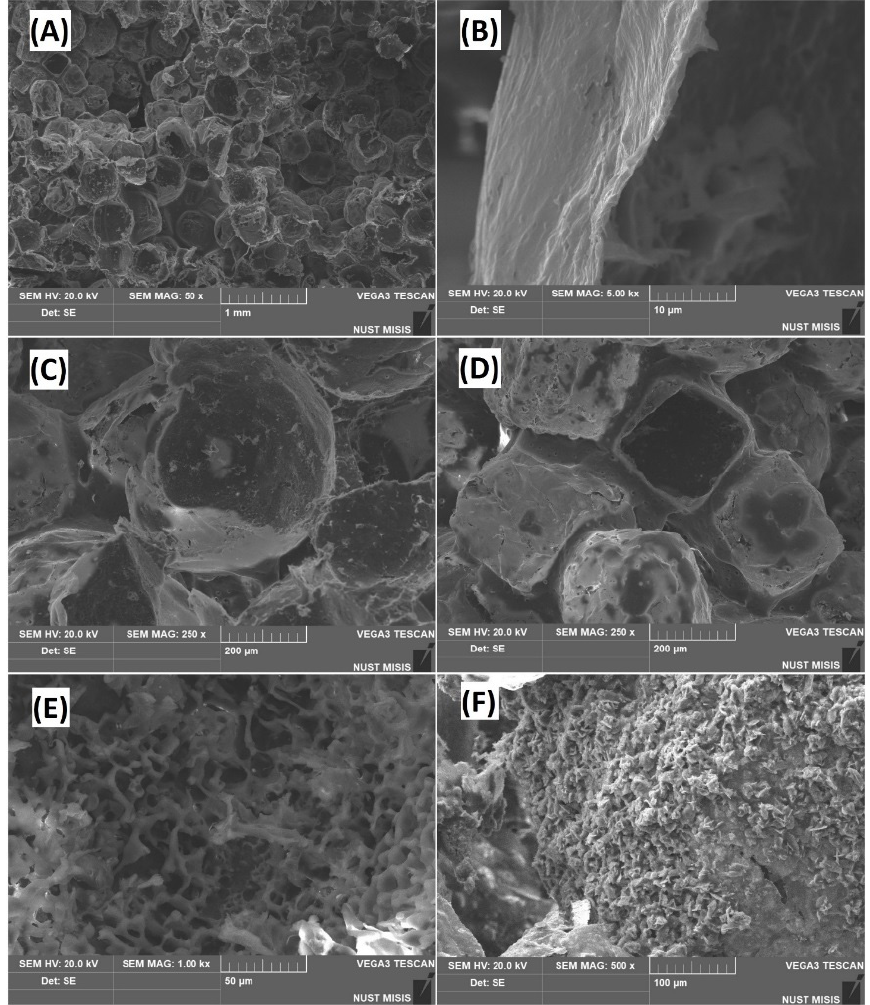
Figure 1. The microstructure of polylactide acid/hydroxyapatite (PLA/HA) composite sample: general view ( A ); pore “wall” ( B ); spherical ( C ), and cubic ( D ) pores; microrelief ( E ); aggregated hydroxyapatite (HA) particles ( F ).